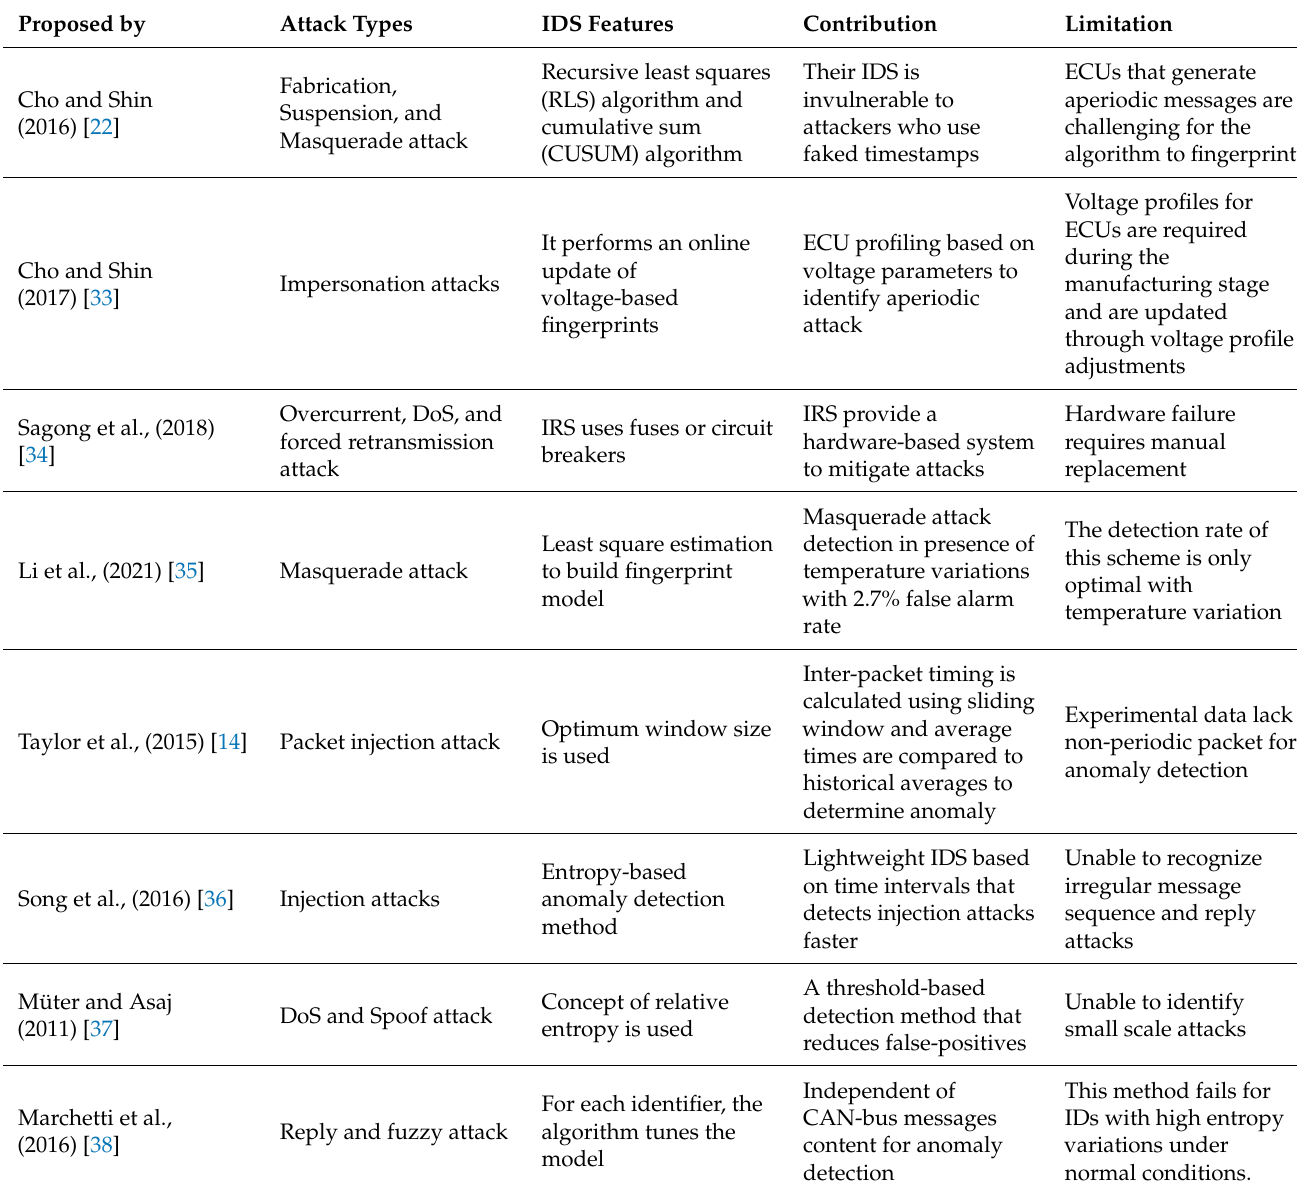
Table 2. Summary of the related methodologies for the CAN